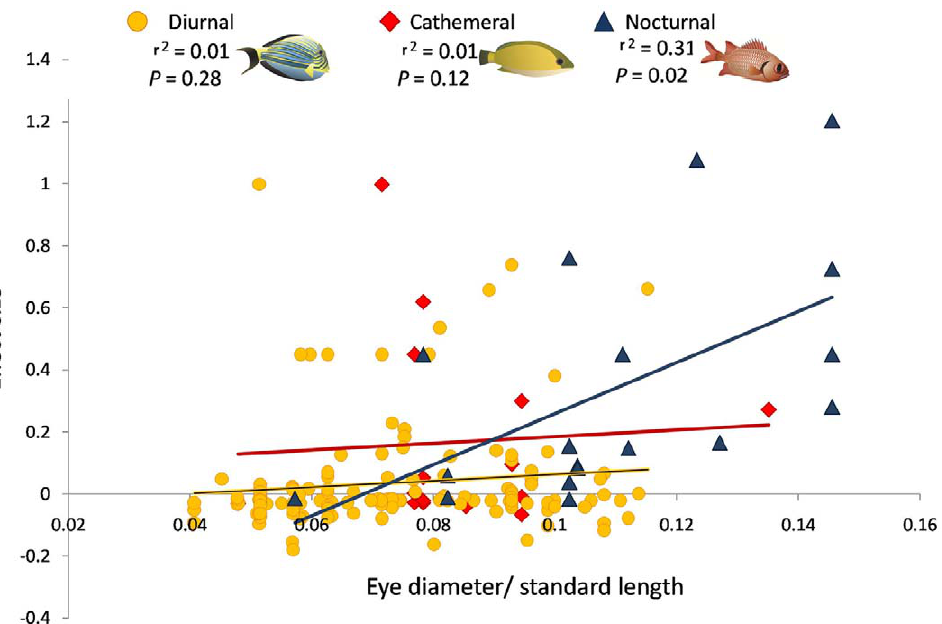
Figure 2. Effect sizes of reef fish density regressed against the ratio of fish eye diameter to standard length (SL). Large effect size values represent strong increases in density at predator impoverished Tabuaeran Atoll. Nocturnal, diurnal and cathemeral are segregated in the plot. Fish with large eye diameter: SL are thought to be increasingly well adapted for functioning at night. The most dark adapted fish showed the strongest responses to predator depletions. There was no significant relationship between effect size response and eye diameter: SL for diurnal or cathemeral fishes.